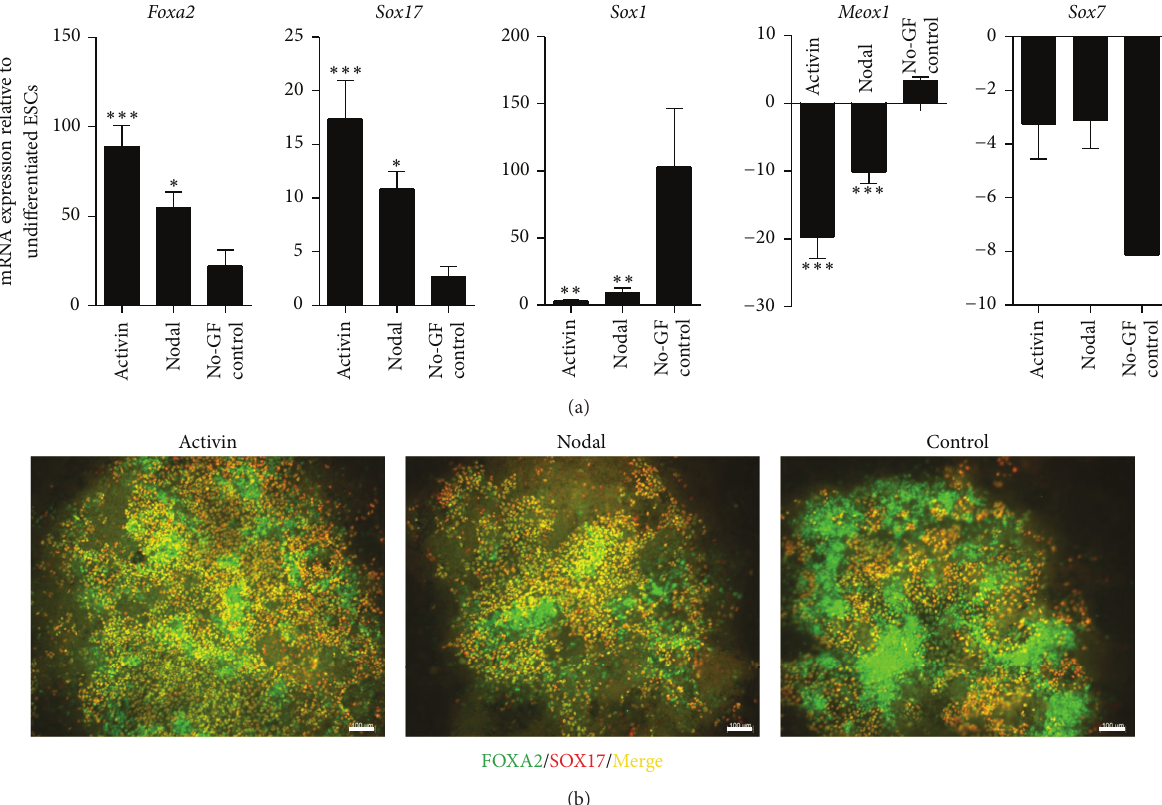
Figure 2: Markers of DE are highly expressed in Nodal and Activin A treated cells, whereas markers of other lineages, including ectoderm, mesoderm, and extraembryonic endoderm are repressed. (a) DE markers, Sox17 and Foxa2 , are upregulated in contrast to the genes of other germlayers,ectoderm( Sox1 ),mesoderm( Meox1 ),andextraembryonicendoderm(Sox7)inNodalandActivinAtreatedcultures. 𝑁 = 3 .Data are presented as mean ± SEM. Asterisks indicate 𝑃 values on comparison with no-growth factor treated (No-GF) control cultures: ∗ 𝑃 < 0.05 , ∗∗ 𝑃 < 0.01 , and ∗∗∗ 𝑃 < 0.001 determined by one-way ANOVA with Tukey’s multiple comparison test. (b) Activin A and Nodal treatment lead to substantial number of FOXA2 + SOX17 + cells, whereas the No-GF control cultures generate FOXA2 + SOX17 − populations. Scale bars, 100 𝜇